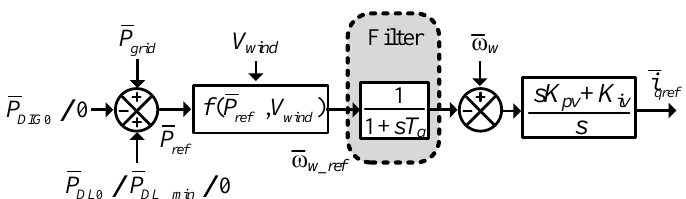
Figure 7. Speed controller of the wind unit with the filter proposed to reduce the rate of change of the wind turbine speed.